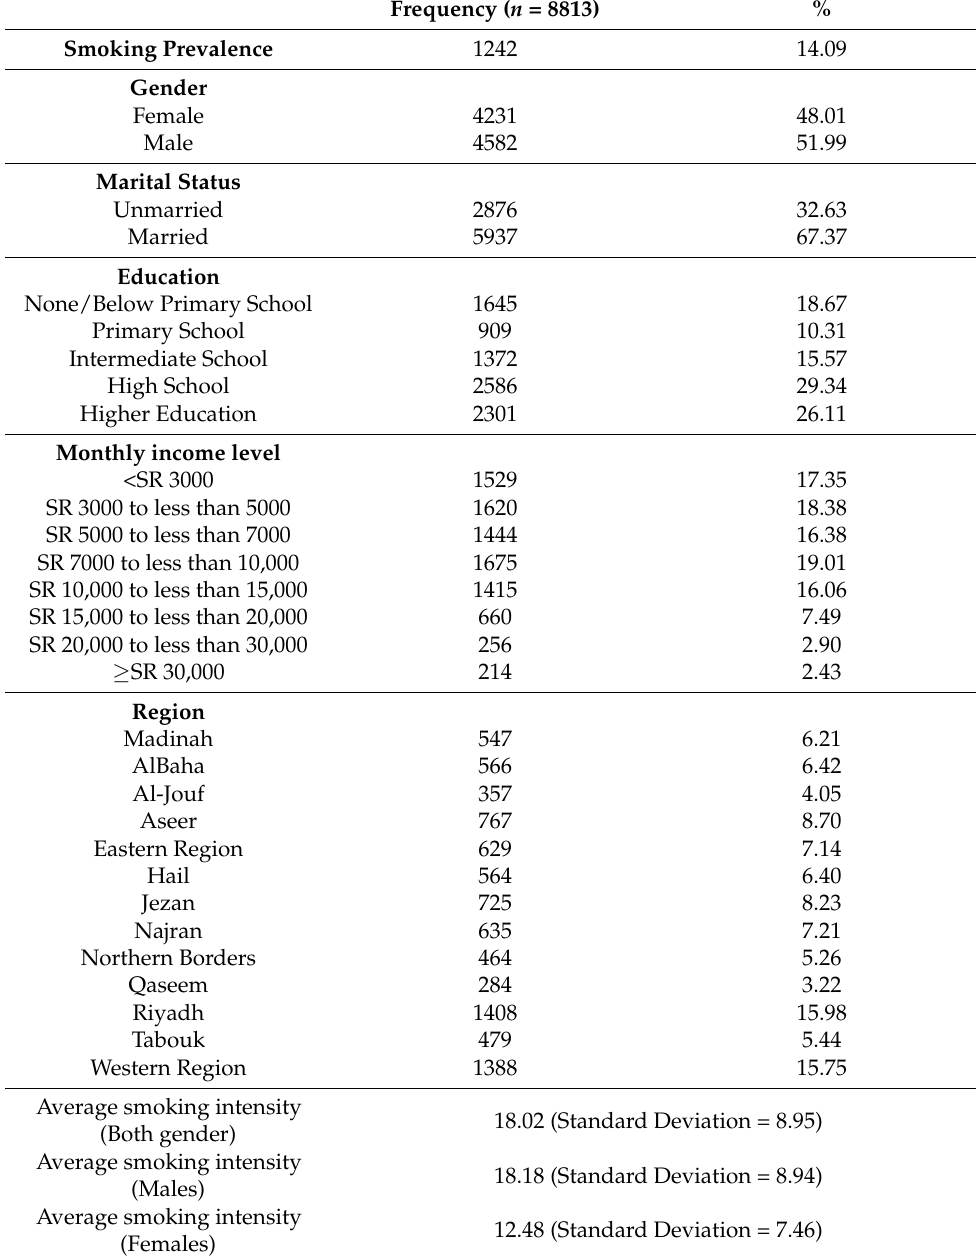
Table 1. Descriptive statistics of the